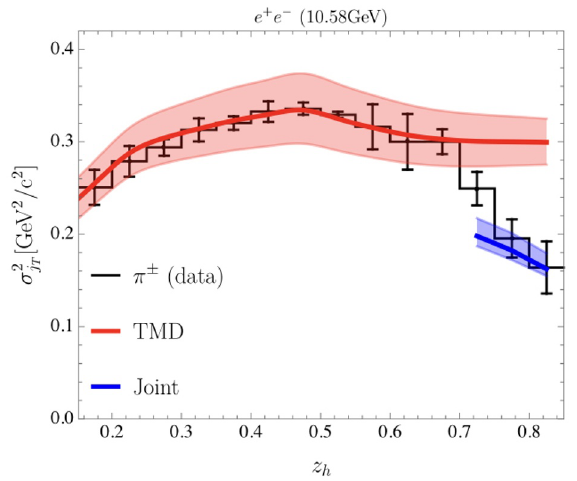
Figure 5 . Gaussian widths for pion using TMD resummation (red band) and joint resummation (blue band) as a function of z h in the thrust bin 0 . 5 < T < 1 . 0 . Data points are constructed by charged pion differential cross sections measured at Belle